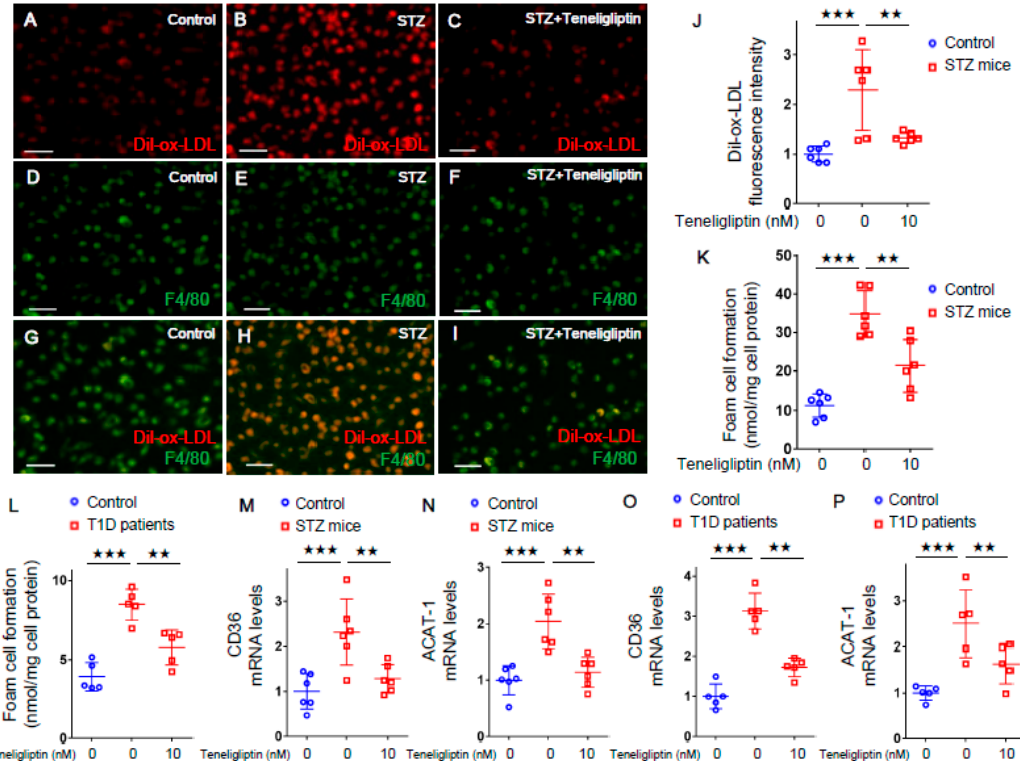
Figure 1. Effects of teneligliptin on oxidized low-density lipoprotein (ox-LDL) uptake, foam cell formation, and CD36 and ACAT-1 gene expression in macrophages extracted from type 1 diabetes (T1D) model mice and T1D patients. ( A–I ) Representative immunofluorescent staining images in the peritoneal macrophages isolated from wild-type mice and T1D model mice. Dil-ox-LDL staining cells were in red, and F4/80 expressing cells were in green. Scale bars represent 50 µm. ( J ) Fluorescence intensity of Dil-ox-LDL per area. ( K ) and ( L ) Foam cell formation was evaluated by the radioactivity of cholesterol [ 3 H] oleate. ( M–P ) Gene expression levels of CD36 ( M , O ) and ACAT1 ( N , P ) in peritoneal macrophages isolated from mice and in monocyte-derived macrophages from humans. ( J , M–P ) are normalized to the control levels.( A–K , M , N ); number = 6 for each group. L, O, and P, number = 6 for control group. number = 5 for each T1D group. *** p < 0.005, ** p < 0.01.